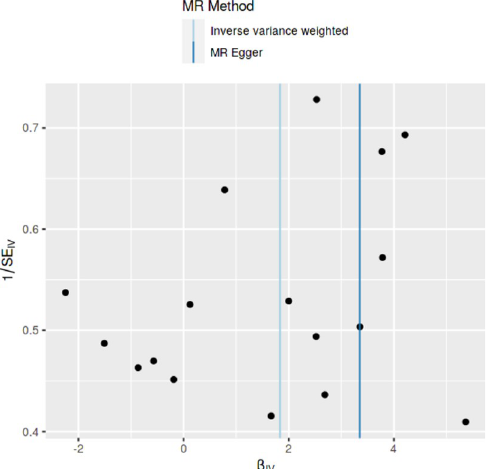
Fig 16. Funnel plot of hip circumference as the exposure, against polycystic ovarian syndrome as the